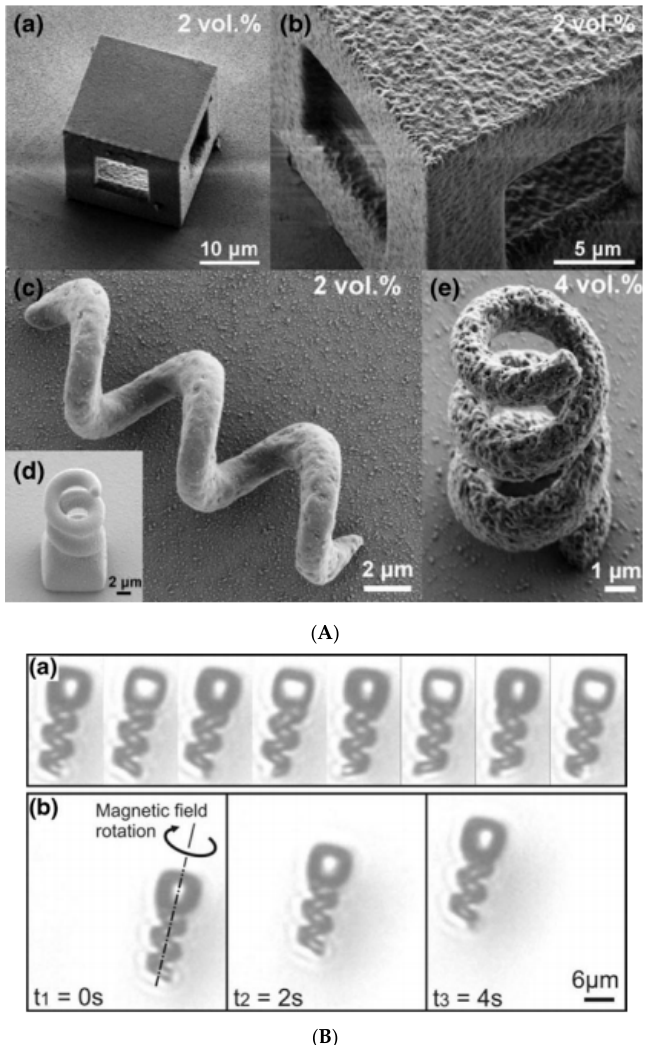
Figure 14. Swimming magnetic microrobots. Ferrofluid used for preparation: 11 nm magnetite NPs in γ -butyrolacton (GBL) carrier liquid. ( A ) SEM images from magnetic polymer composite (MPC)